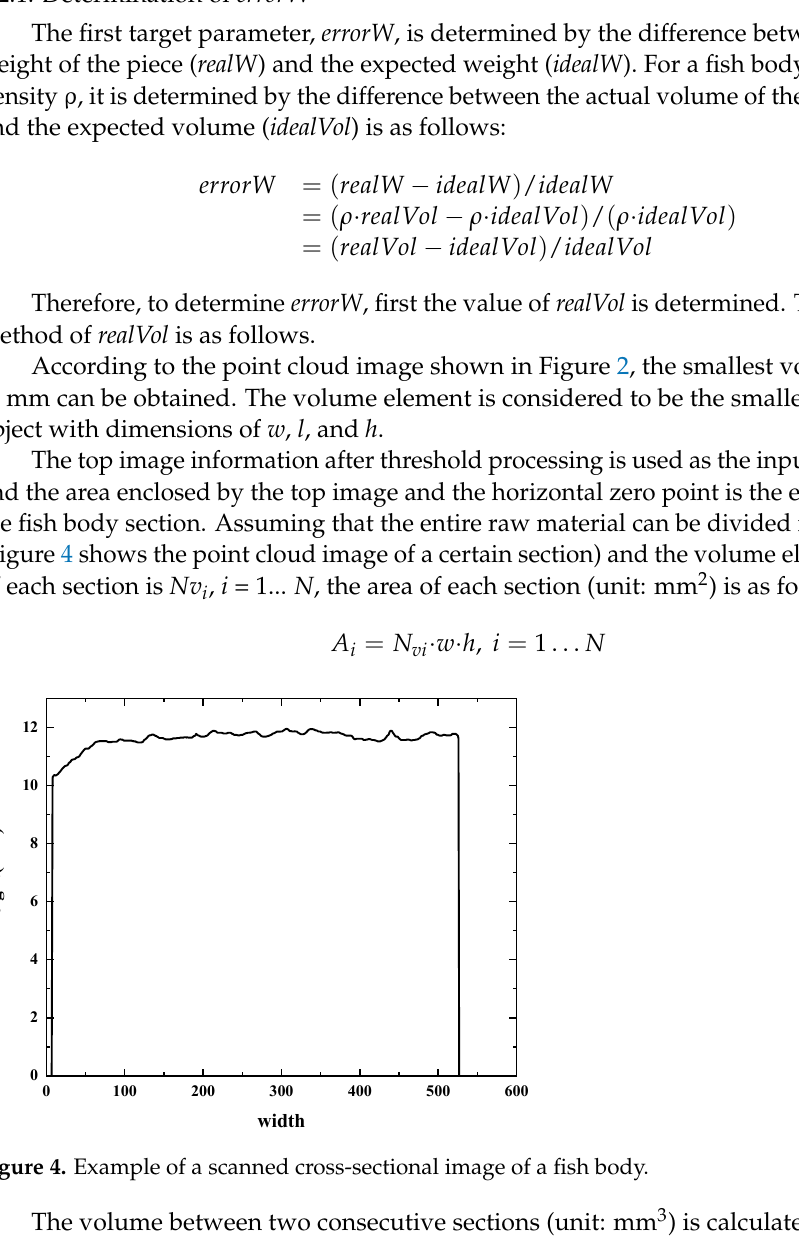
shown in Figure